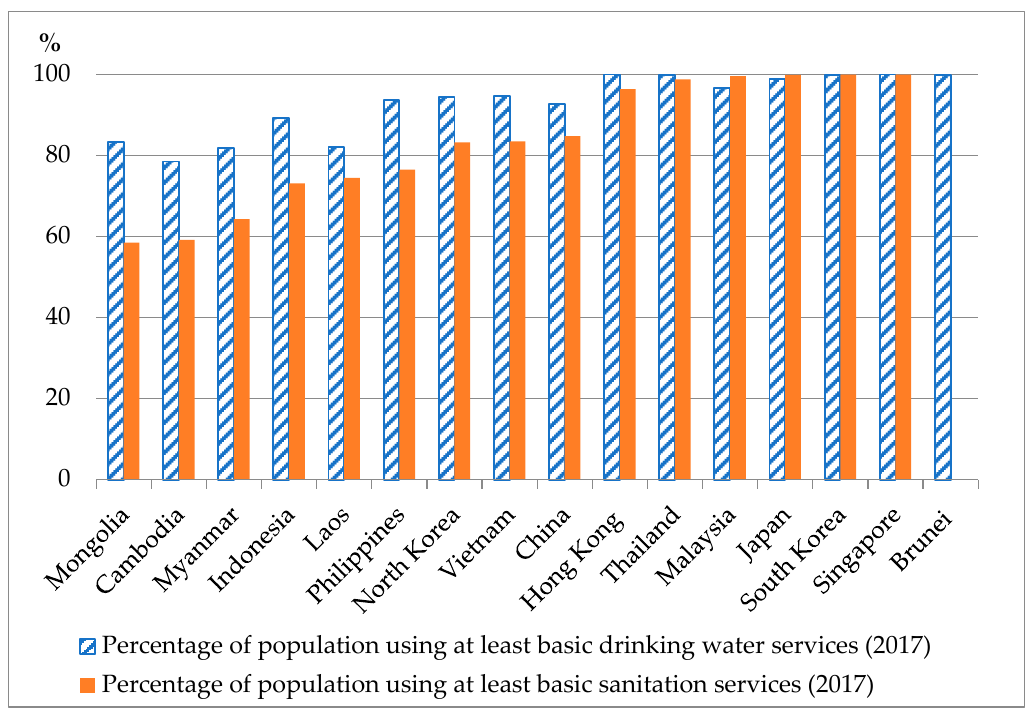
Figure 7. Percentage of population using at least basic drinking water and sanitation services in East and Southeast Asian economies, 2017. (Source: data retrieved from [4]).